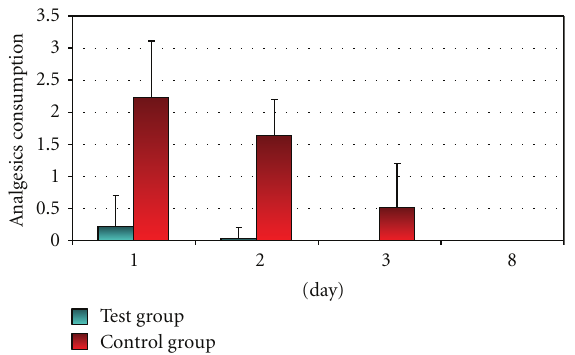
Figure 4: Graphic distribution of average painkillers’ intake (in pts.) for patients from test and control group.